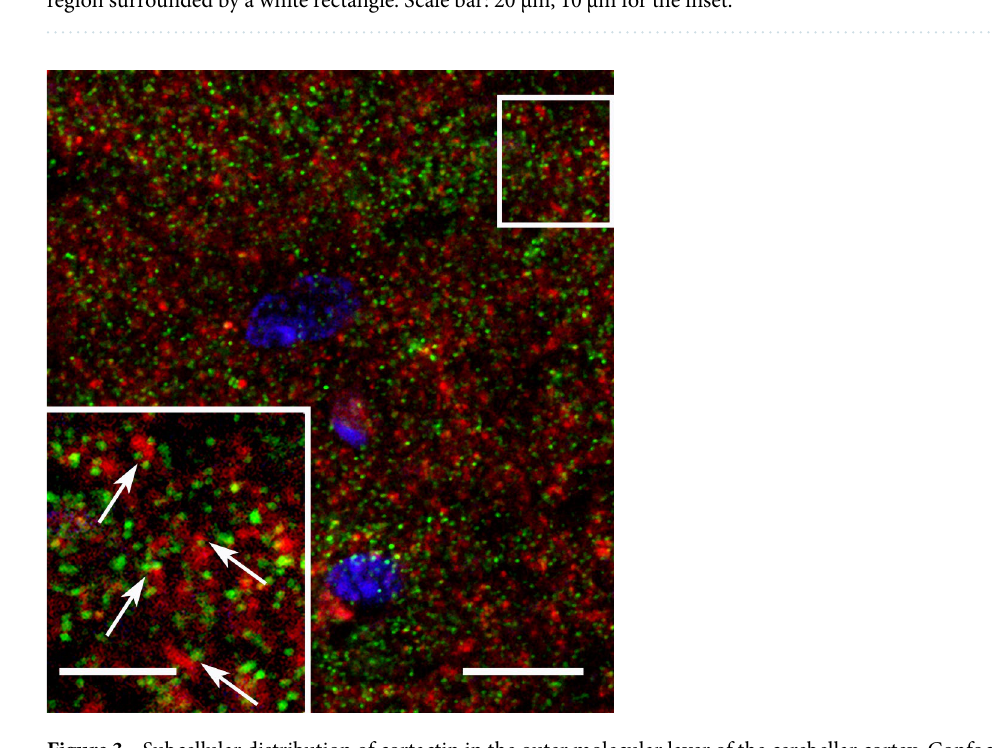
Figure 3. Subcellular distribution of cortactin in the outer molecular layer of the cerebellar cortex. Confocal microscopy shows cortactin (Cy3, red) and the presynaptic marker synaptophysin (Alexa-488, green); cell nuclei (DAPI) are shown in blue. The apposition of puncta immunopositive for cortactin and synaptophysin (arrows in inset) suggest that cortactin is likely localized to postsynaptic structures. The inset is an expanded image of the region surrounded by a white rectangle. Scale bar: 10 µm (5 µm for